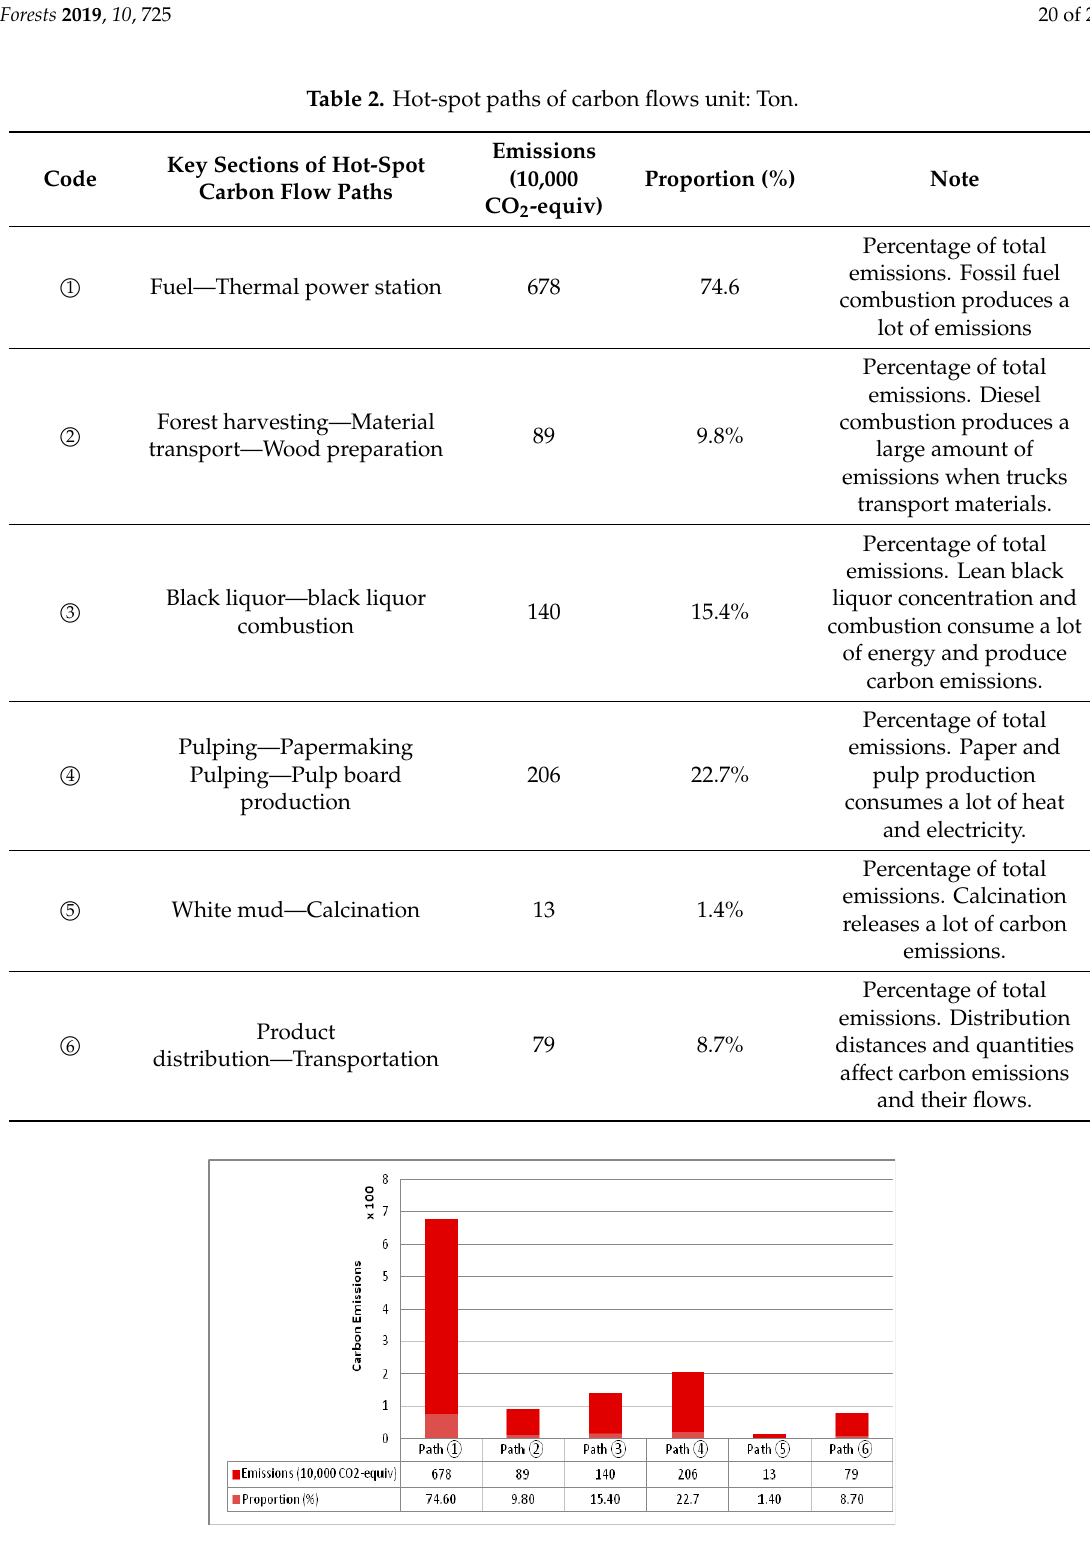
Figure 13. Hot-spot carbon flow paths.